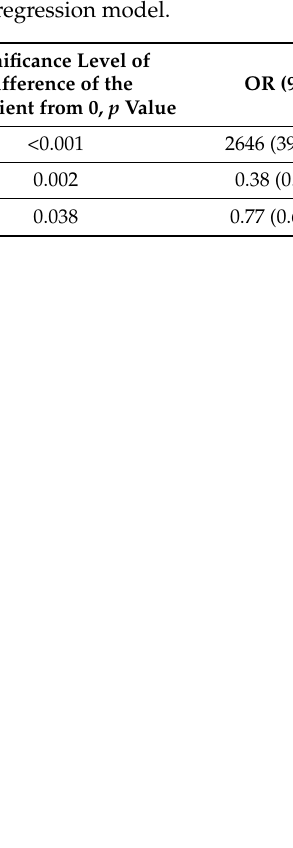
Table 2 presents the results of the multifactor logistic regression analysis. Table 2. Analysis of risk of death in a three ‐ factor logistic regression model.